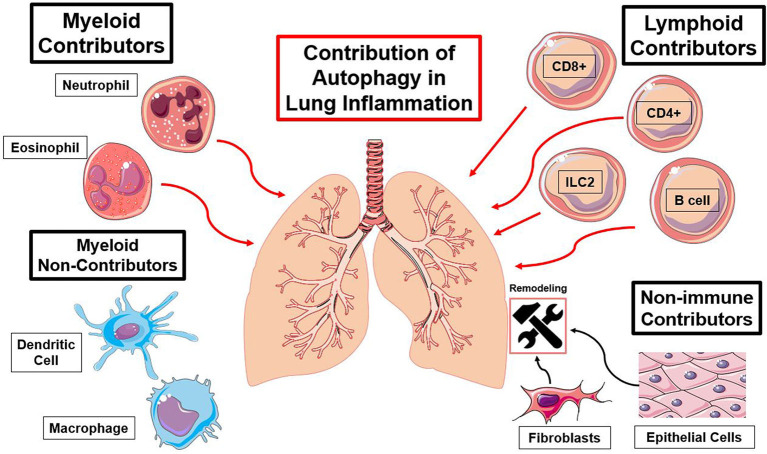
Summary of immune cell types and the functions of autophagy contributing to lung inflammation. Red lines indicate an autophagy-mediated increase in inflammation and black lines indicate an autophagy-mediated contribution to lung remodeling [(23, 25, 27, 30, 37, 41, 57–59, 63, 66, 74, 79, 89, 96, 97, 110, 127), (116, 122, 123, 137, 140, 154)].